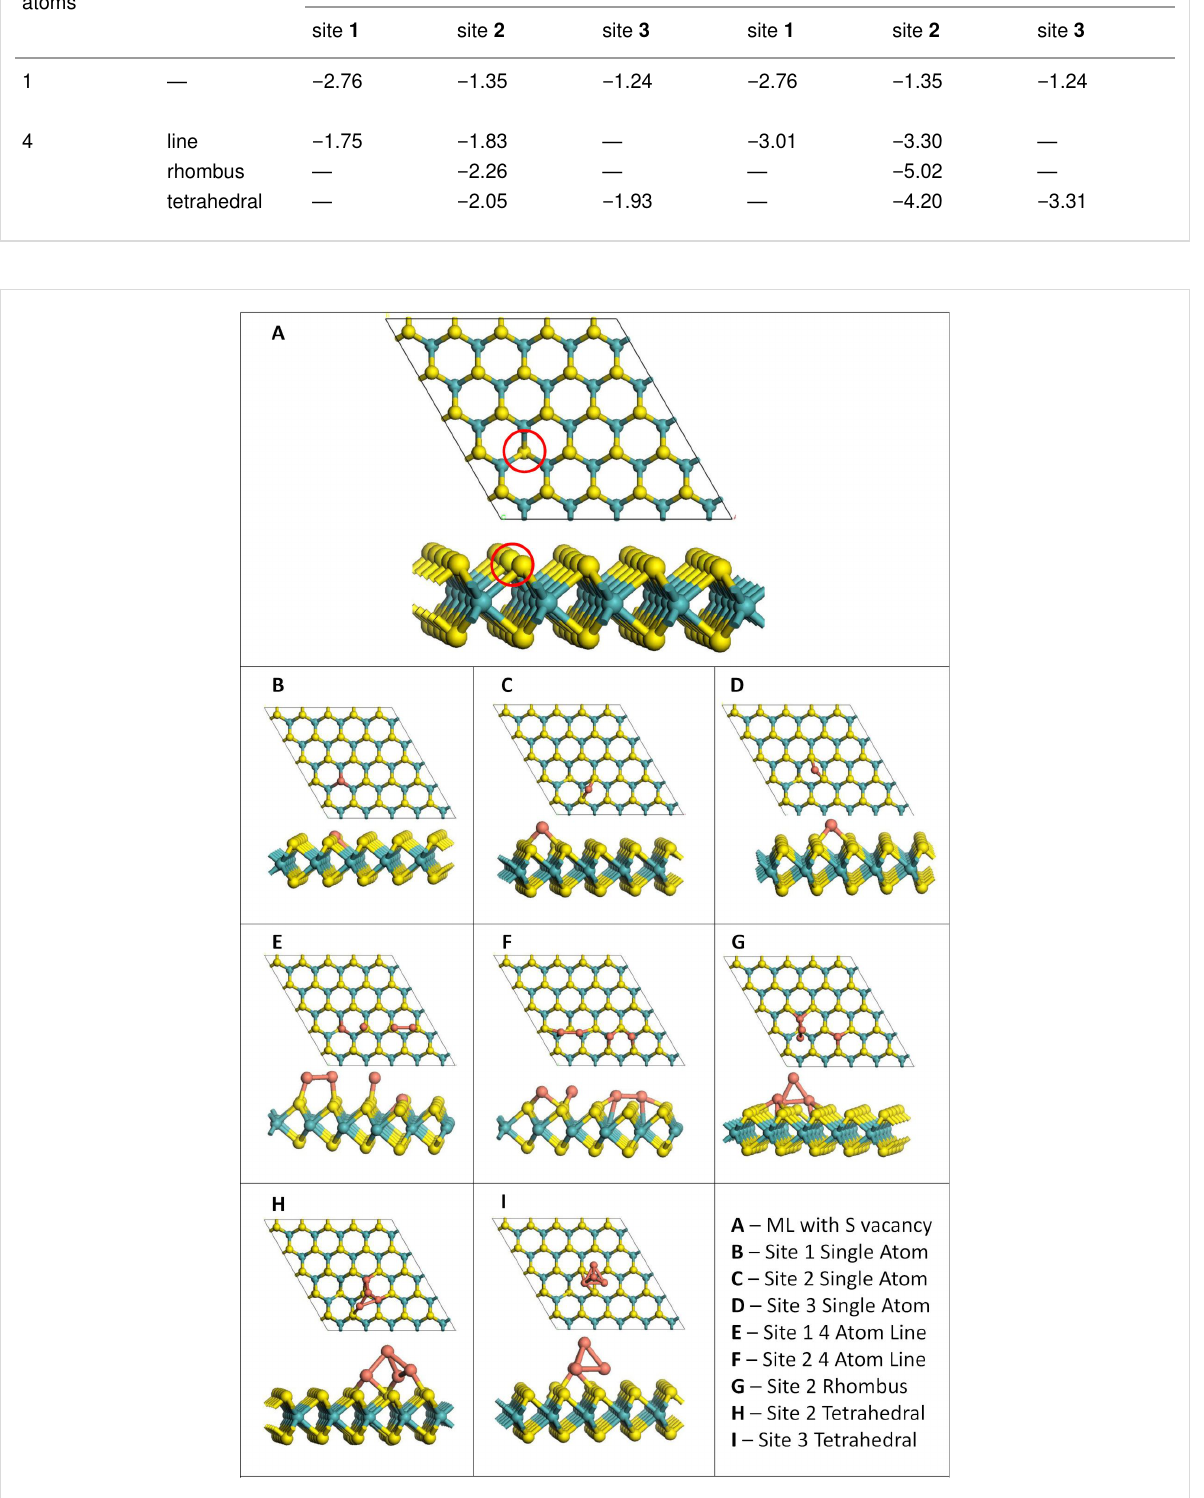
Table 7: Computed binding energies per Cu atom of one and four Cu atoms and binding energies of the Cu 4 nanocluster relative to a free Cu 4 nano- cluster on MoS 2 with a sulfur vacancy for the adsorption of a single Cu atom and the Cu 4 nanocluster. number of Cu atoms